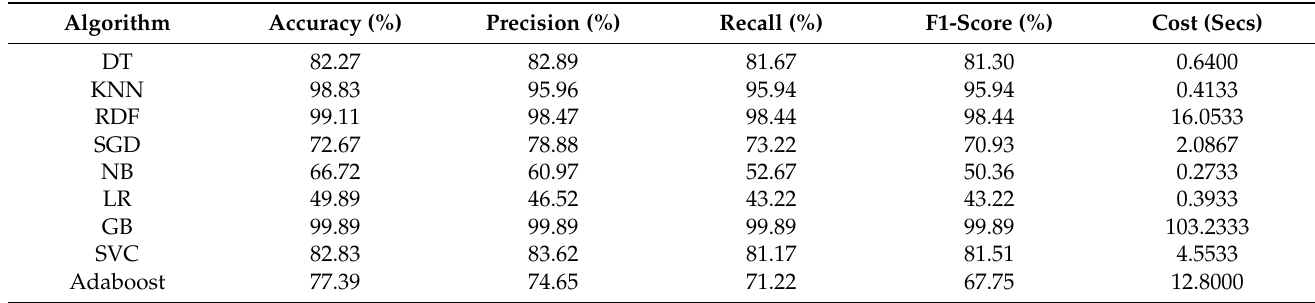
Figure 21. Fault Visualization plot aided with PCA for a impedance dataset. Table 10. Global performance comparison of ML models using all feature